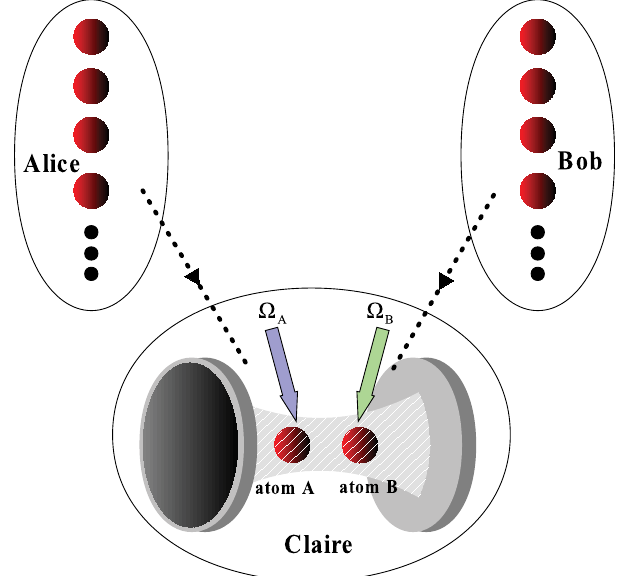
Figure 2. The setup for fusion of two W states. Both Alice and Bob transmit one qubit to Claire, under the condition π = Δ Ω t /(2 ) 2 , Claire detects the state of two atoms and informs them if the task is